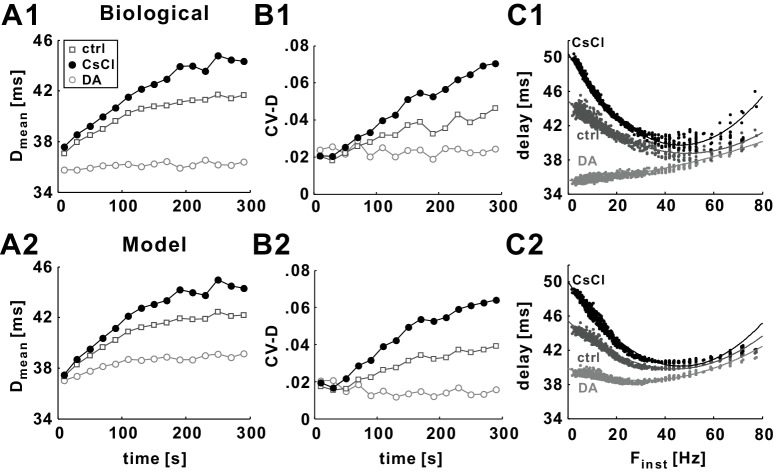
Changing the level of Ih in the model mimics the experimental effects of CsCl and DA.(A1–B1) At the slow timescale, DA results in an increase of gh, which in turn causes Dmean and CV-D stay to remain relatively constant in response to a 5 min 10 Hz Poisson stimulation. In contrast, blocking Ih with CsCl results in an increase in Dmean and CV-D (Ballo et al., 2012). (A2–B2) This effect is mimicked by changing gh levels and the activation curve of Ih in the model. (C1) Changes in gh levels by DA or CsCl result in changes in the minimum delay (Dmin) and curvature (κmin) values in the delay vs. Finst plots (for the 5th minute of the Poisson stimulation). (C2) These effects are mimicked by the models with different activity level of Ih (see Materials and methods and Tables 1 and 2 for details).